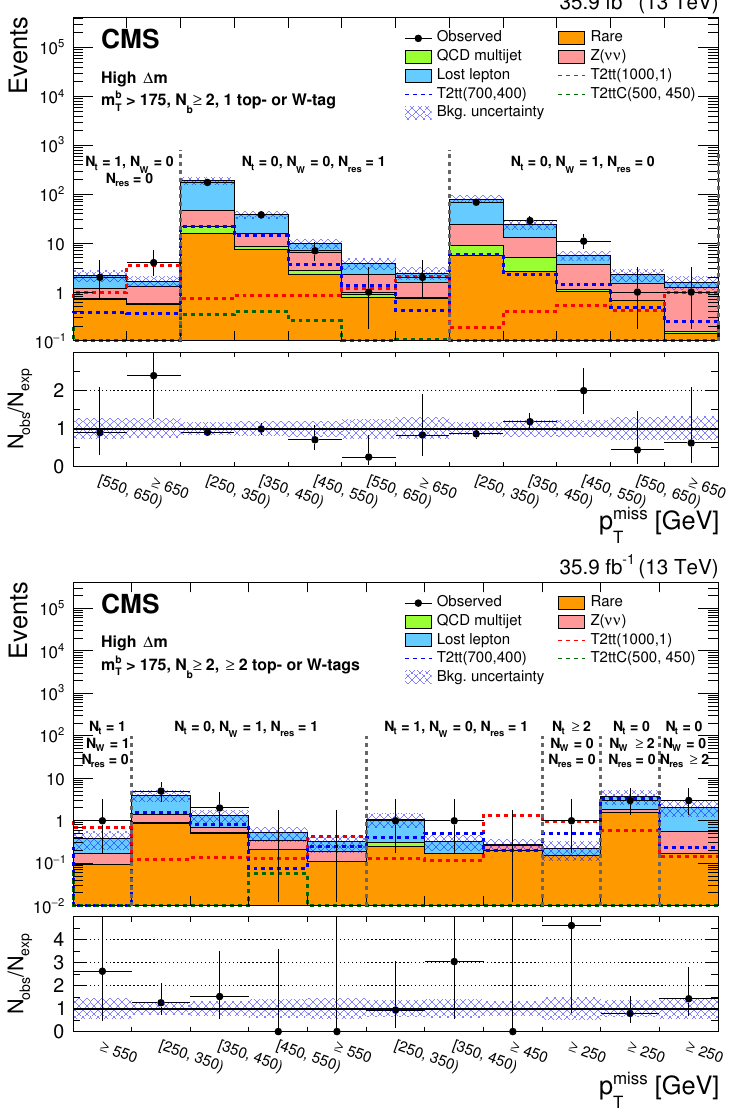
Figure 8 . Observed data events and SM background predictions for the high (cid:1) m search regions with one (upper), and at least two (lower) top quark or W boson candidates. Details of the selection applied is displayed on each plot. Ratios of the observed to SM predicted event counts are shown in the lower panel of each plot. The shaded blue band represents the statistical and systematic uncertainty on the prediction. Units are GeV.